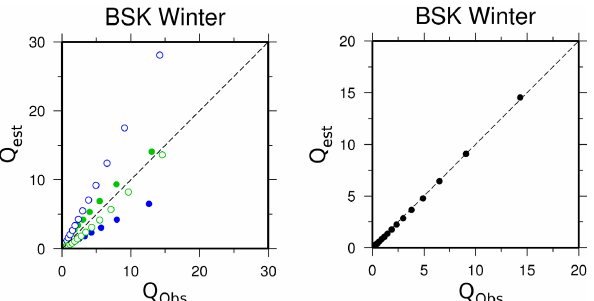
Fig. 5. Left: quantiles of validation-subsets, estimated by transfor- mation of the cumulative distribution function. Blue dots (circles): validation-subset consists of the first (second) half of all winter val- ues. Green dots (circles): validation-subset consists of all winter values with an even (odd) entry number. Right: quantiles estimated by multiple linear regression including all winter values.